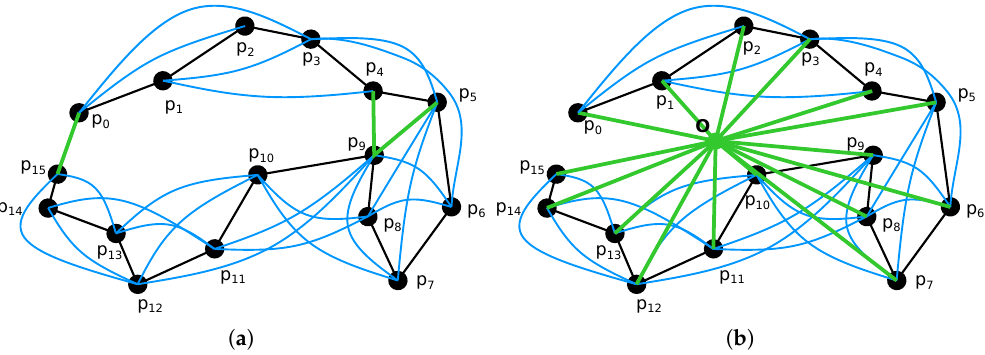
Figure 15. Pose graph as the output of point cloud registration and the input of SLAM optimization. The goal is to estimate 6DoF poses P 1 , P 2 , . . . , P N of graph nodes (vertices) p 1 , p 2 ,..., p 1 5 in the trajectory. The edges represent the transformations between LiDAR frames for given nodes estimated by point cloud registration. Black edges represent transformations between consequent frames, blue edges are for transformations within a certain neighborhood (maximum distance of three frames in this example) and the green edges (in ( a )) represent visual loops of revisited places detected by a significant overlap between the given frames. When GNSS subsystem is available ( b ), additional visual loops are introduced as transformations from the origin O of some local geodetic (orthogonal NED) coordinate